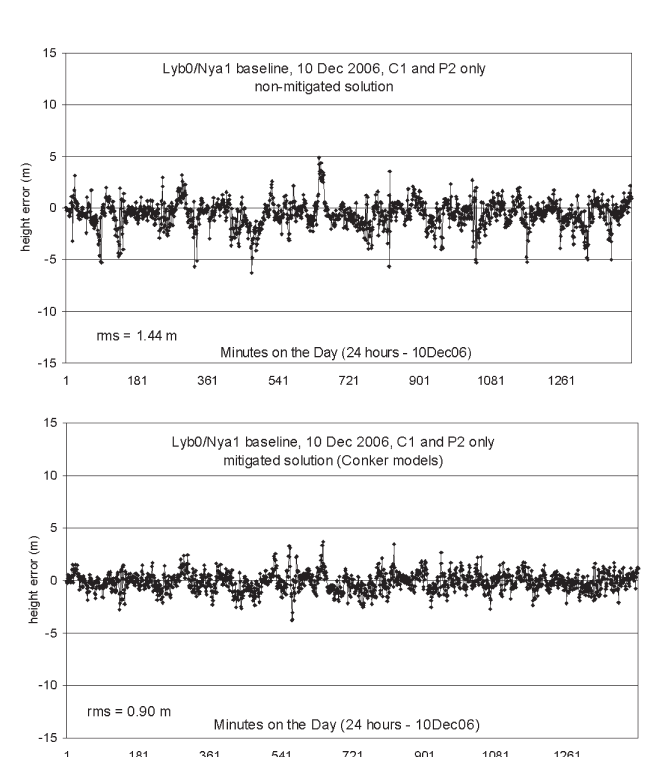
Fig. 4. 24 hours (10 Dec 2006) time series of errors in height for baseline Lyb0/Nya1 when epochwise (1 minute) non-mitigated solution (left below) and mitigated solution (right above) are computed based only on C 1 and P 2